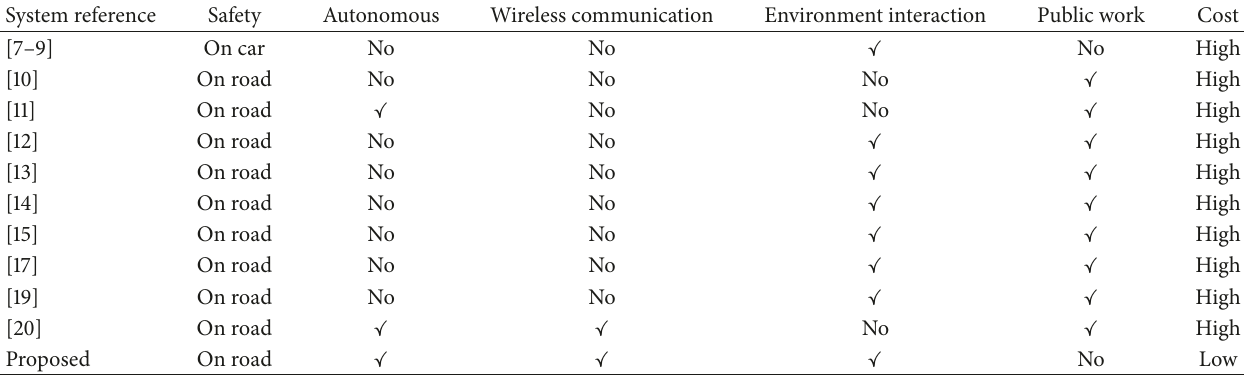
Table 1: Comparison of features and capabilities for various approaches in the state of the art. System